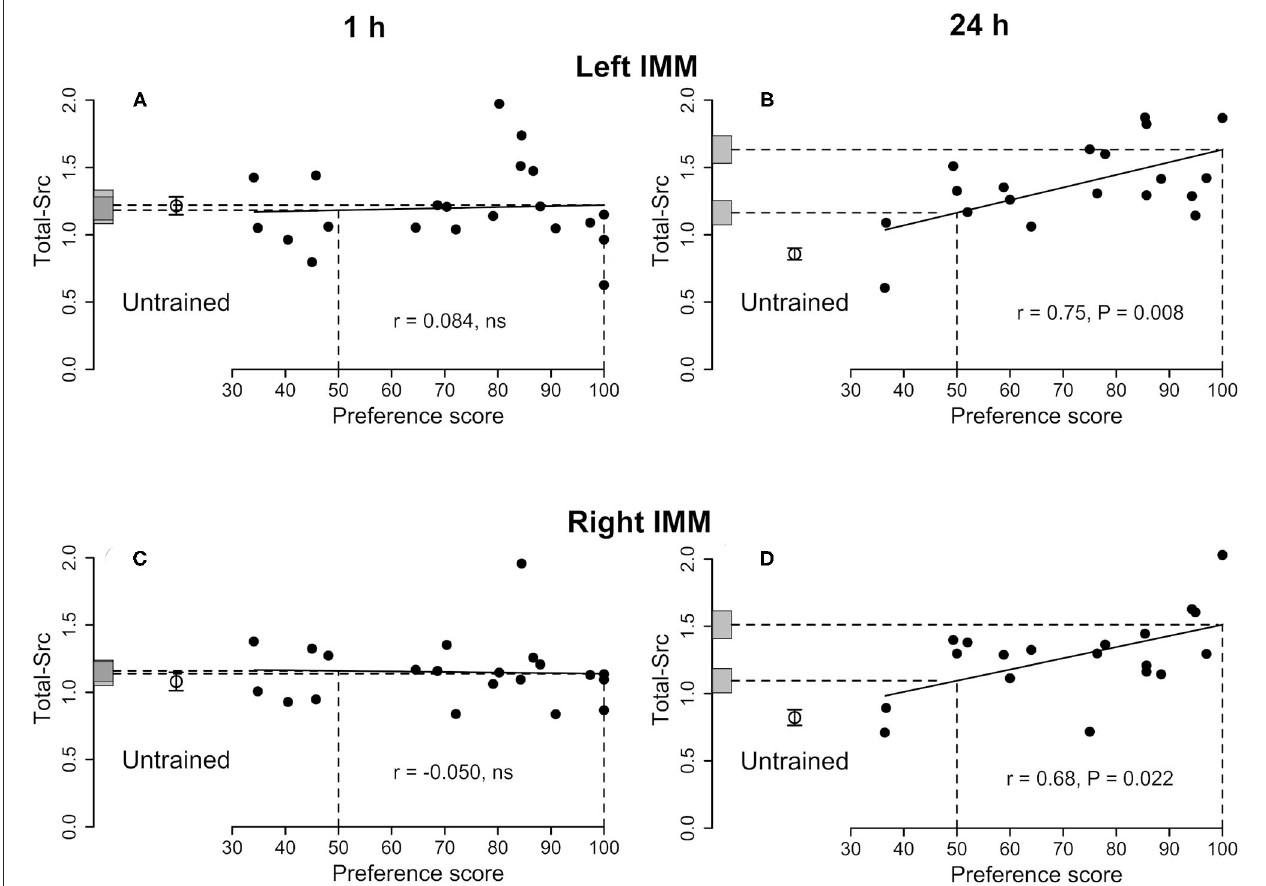
FIGURE 1 | Left IMM and right IMM, 1 and 24h after the end of training. Standardized relative amount of Total-Src plotted against preference score. Filled circles, trained chicks. Open circles and associated bars, mean level in untrained chicks ± SEM. Vertical dashed lines, preference scores 50 (no preference/no learning) and 100 (approach only to the training stimulus /strong learning); horizontal dashed lines, y -axis intercepts for preference scores 50 and 100; gray bars on y -axis, ± SE of intercept. (A) Left IMM and (C) right IMM 1h after the end of training. Correlations are not significant. (B) Left IMM and (D) right IMM 24h after the end of training. For both sides, the correlations are significant and the differences between the untrained mean and the intercept at preference score 100 are also significant. The intercepts at preference score 50 are also significantly higher than the mean of untrained chicks, indicating an effect of training on Total-Src in addition to a learning-related